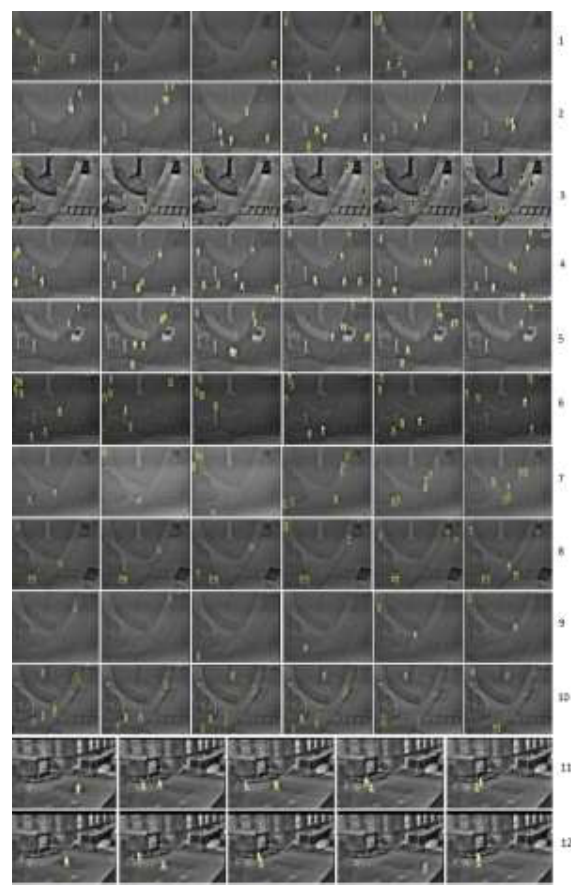
Figure 30. Samples of pedestrians' detection in database 1 (rows 1-10) and database 2 (rows